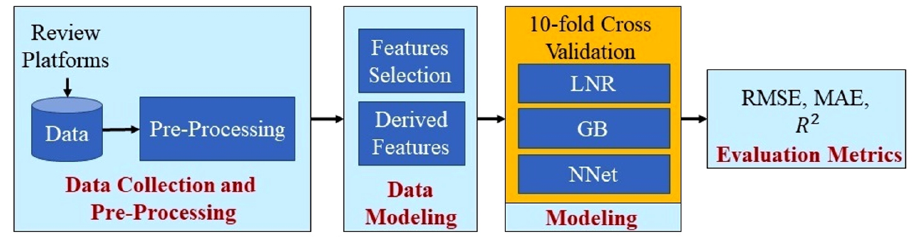
Figure 1. Flow chart of proposed research